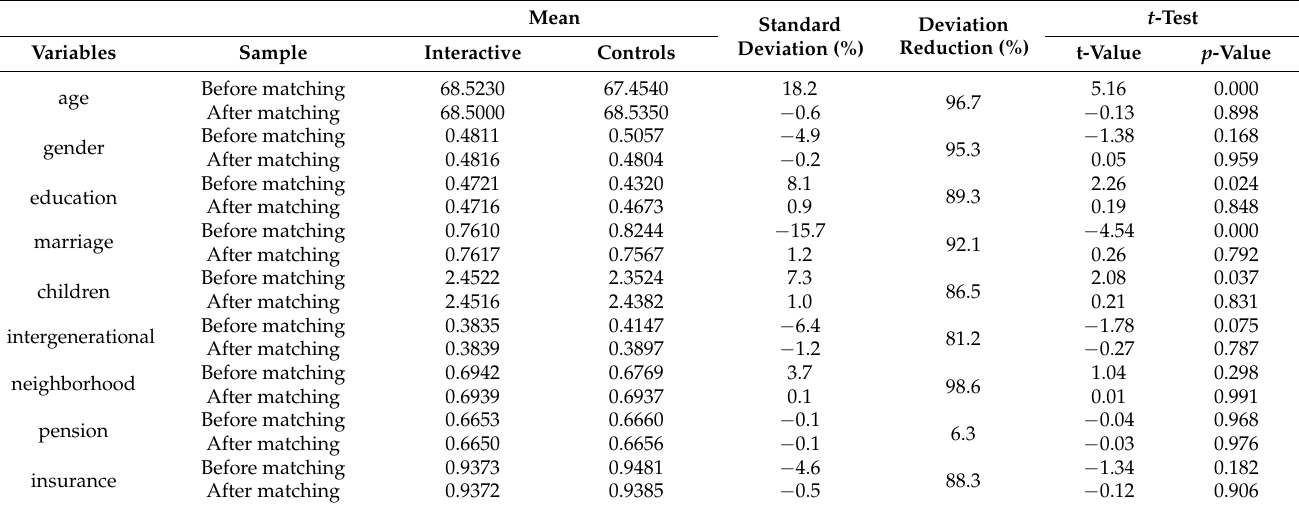
Table 6. Changes in feature variables before and after sample matching (radius).